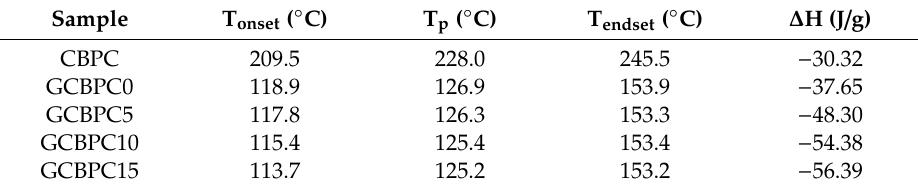
Figure 5. DSC curves of phosphate ceramic materials. Table 4. Curing parameters from DSC curves.